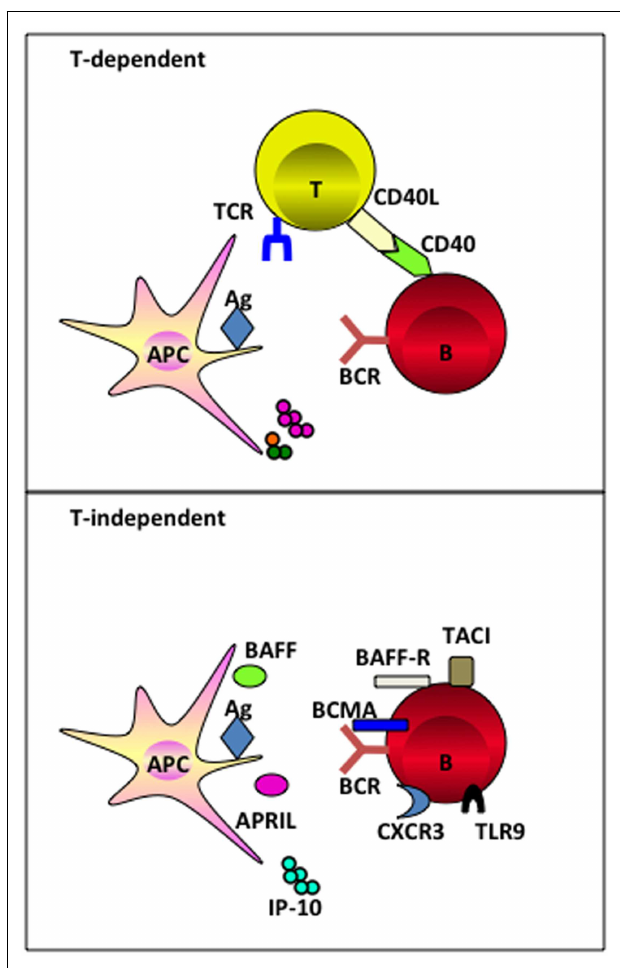
FIGURE 1 |APC subsets induceTI andTD B cell activation . APC subsets including DCs and macrophages, have the capacity to retain and recycle native antigens on their surface and engage with B cell receptor for the signal 1 delivery. Ag-experienced B cells receive cognateT cell signals to form germinal center for the generation of long-lived PCs in aTD manner. Alternatively, APC-derived soluble factors provide late signals to B cells that have the respect receptors during the activation, proliferation, and differentiation, in aTI